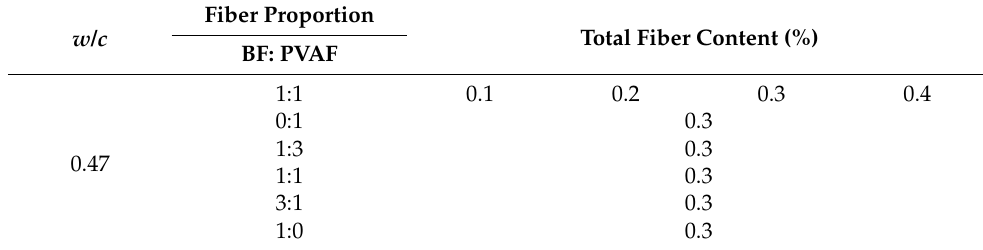
Table 7. Hybrid fiber content and blending